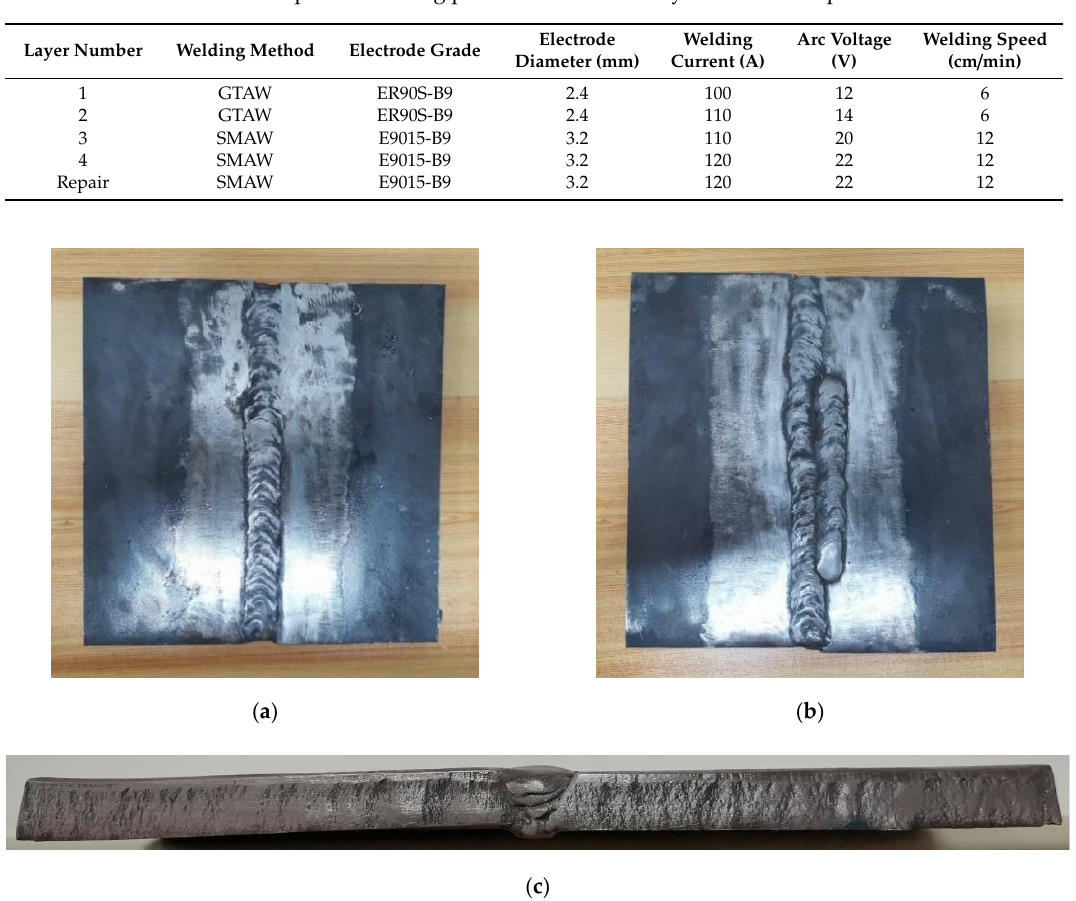
Table 3. Specific welding parameters for each layer and weld repair.